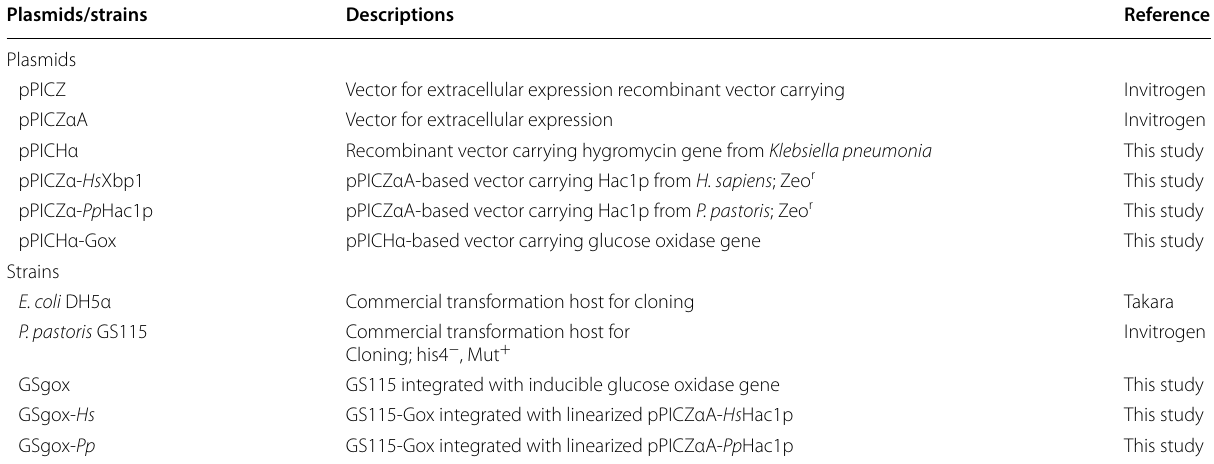
Table 1 Strains and plasmids used in the study